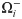
The left plot.Segmentation of SpO2) and its projection on H(HRV) × H(SF) space in the form of SpO2) using (geometric)ANN. The step-like function indicates the value of the Hurst index for each segment. The right plot. The yellow color indicates SpO2)-perceptron value γ = 1, given by (2), Ω+, i.e., normhypoxemia, blue colour indicates γ = −1, Ωi-, i = 1, 2. The grey circles are positioned at the boundary of a convex hull of certain number of points with γ = +1. The analyzed data correspond to a human subject encapsulating 15 hours of SMS acquisition. Each segment contains about 225 data points. The green horizontal line indicates mean of SpO2), the orange represents the mean of the complexity segments.